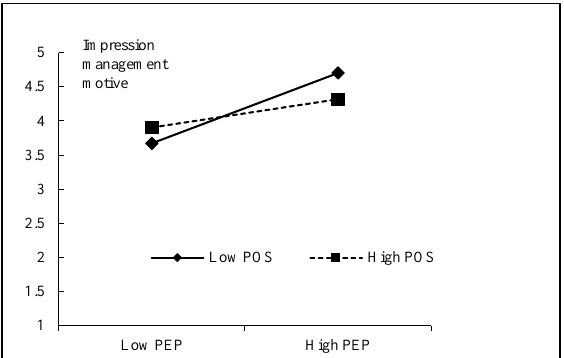
Figure 2. The moderating effect of POS on the relationship between PEP and organizational identi- fication.